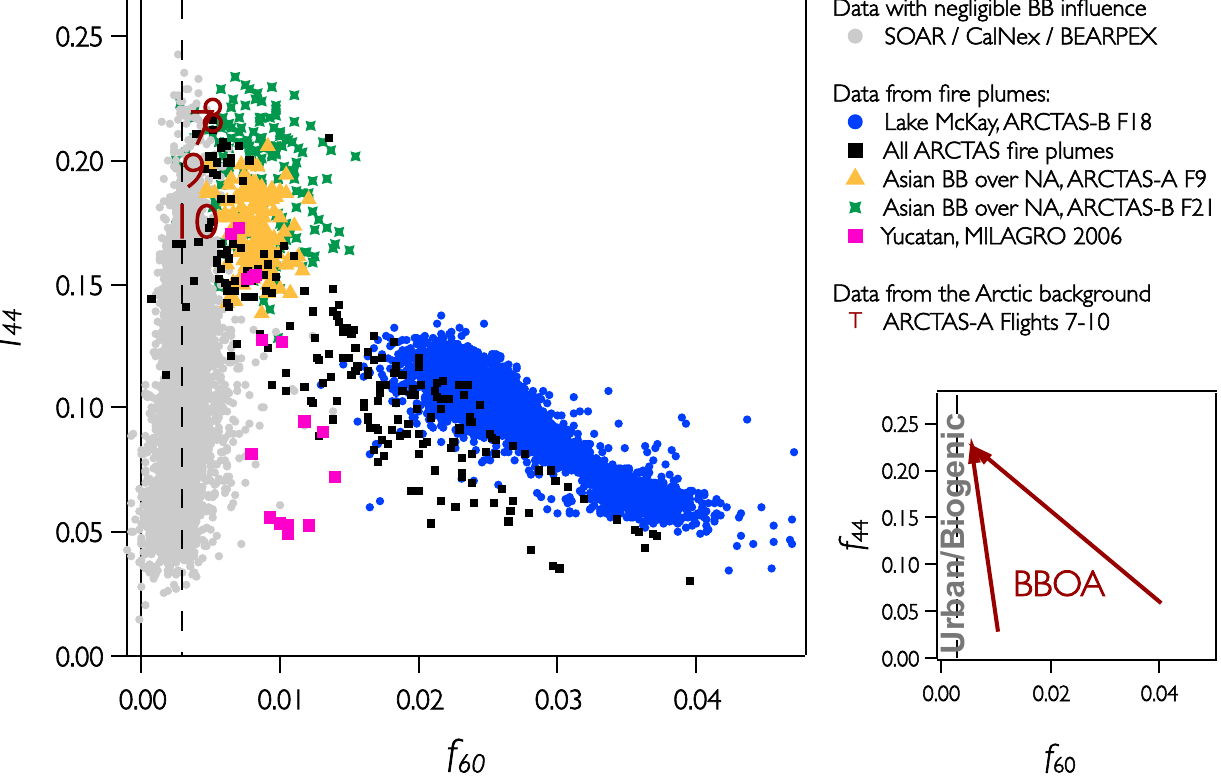
Fig. 4. Summary plot showing f 44 vs. f 60 for all the field measurements discussed in the text. The nominal background value at 0.3% is shown by the vertical dashed line. Right Panel: schematic of the different representations that the non-BB and BB data make in this space.